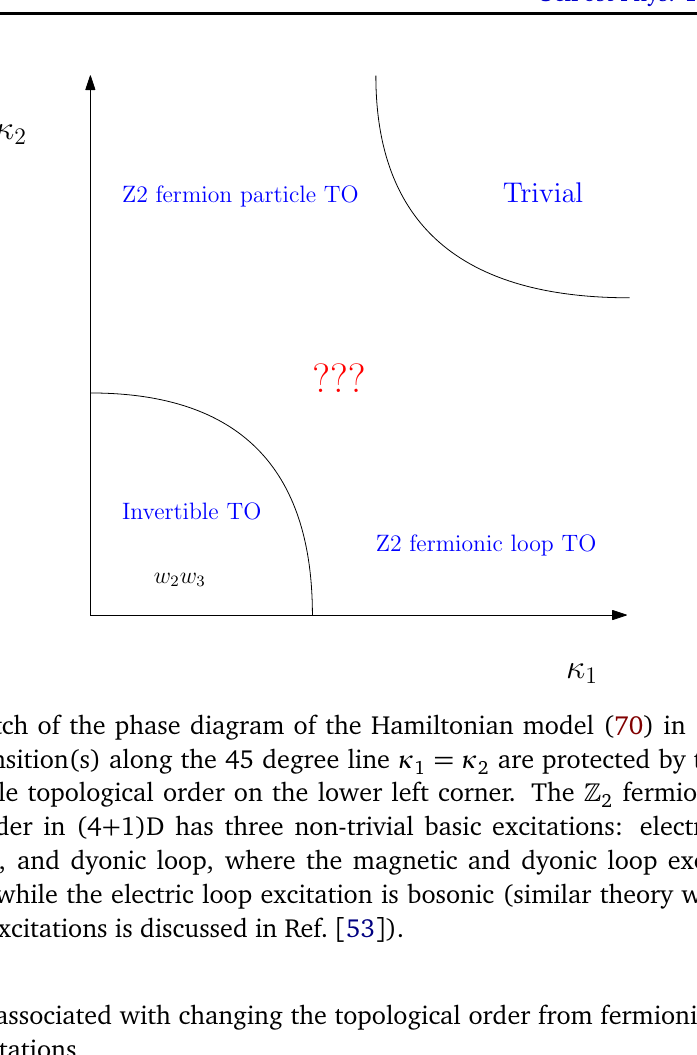
= κ are protected by the non- 1 2 fermionic loop 2